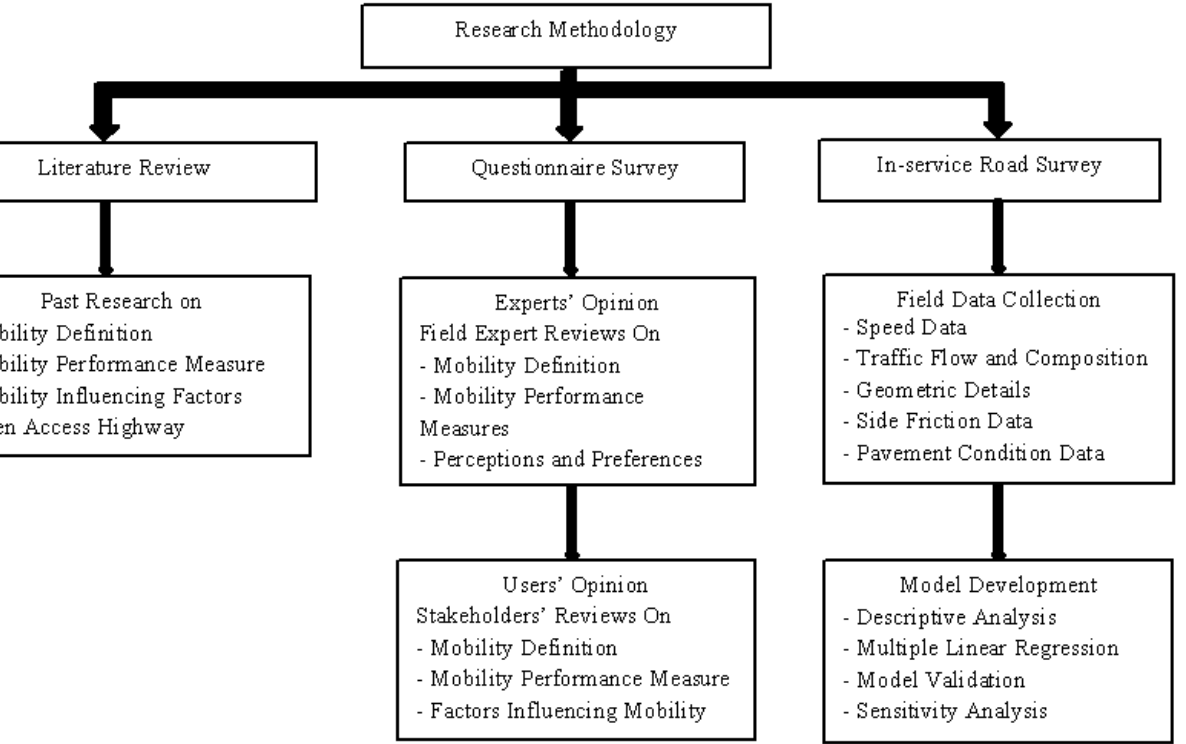
Figure 1. Overview of the Research Methodology.